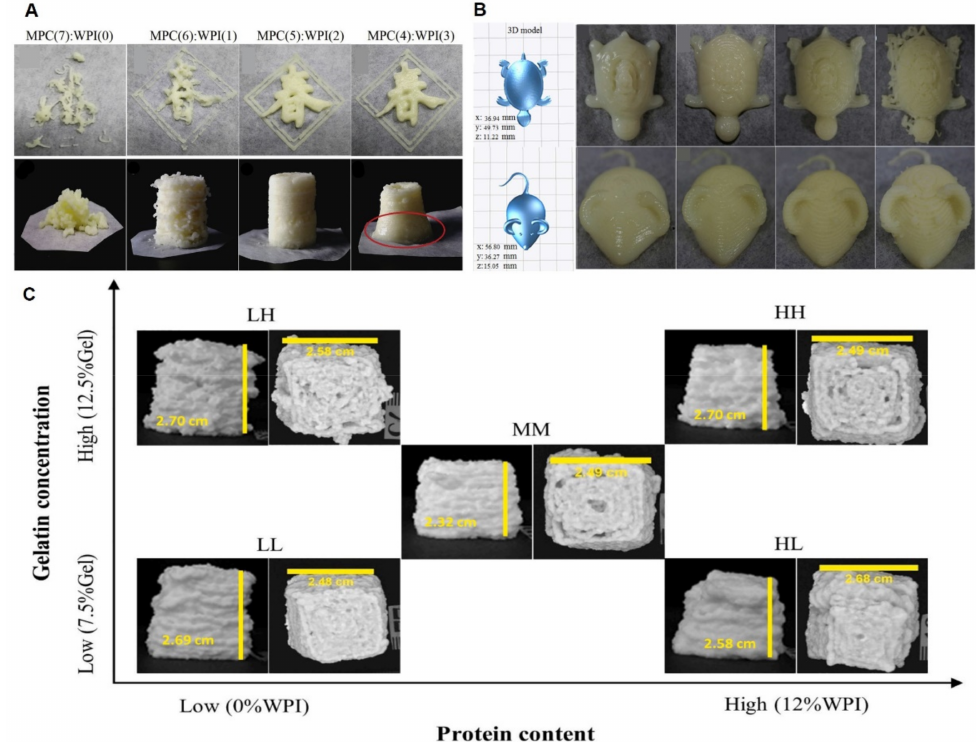
Figure 5. ( A ) 3D-printing constructs of different fractions of MPC and WPI [67]. ( B ) Different total protein content: a/a, 350 g/L; b/b, 400 g/L; c/c, 450 g/L; and d/d, 500 g/L milk protein gel preparation printing results. ( C ) View of 3D-printed gel morphology from the top and side: LL, 0% WPI–7.5% gelatine; LH, 0% WPI–12.5% gelatine; MM, 6% WPI–10% gelatine; HL, 12% WPI– 7.5% gelatine; HH, 12% WPI–12.5% gelatine. Adapted from References [66,71,76], with permission from